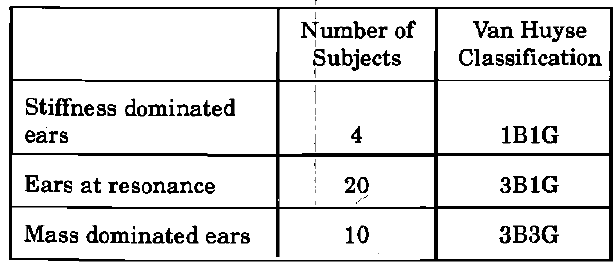
Summary of | baseline transmission characteristics of subjects in this study. (n=34).